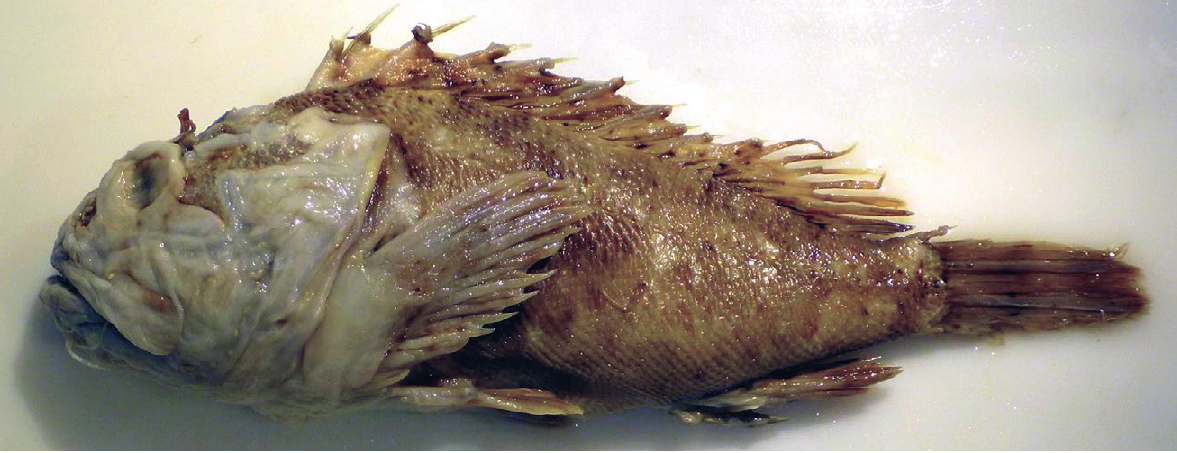
Fig. 4. – Scorpaena porcus Linnaeus, 1758, MNHN 0000-6706, lectotype of Scorpaena erythraea Cuvier in Cuvier and Valenciennes, 1829, specimen 1, 154.7 mm SL, Egypt, Red Sea/probably erroneous, Mediterranean Sea, Alexandria, 1798-1799. Lateral view; photograph of the colouration in preservative taken ca. 218 years after